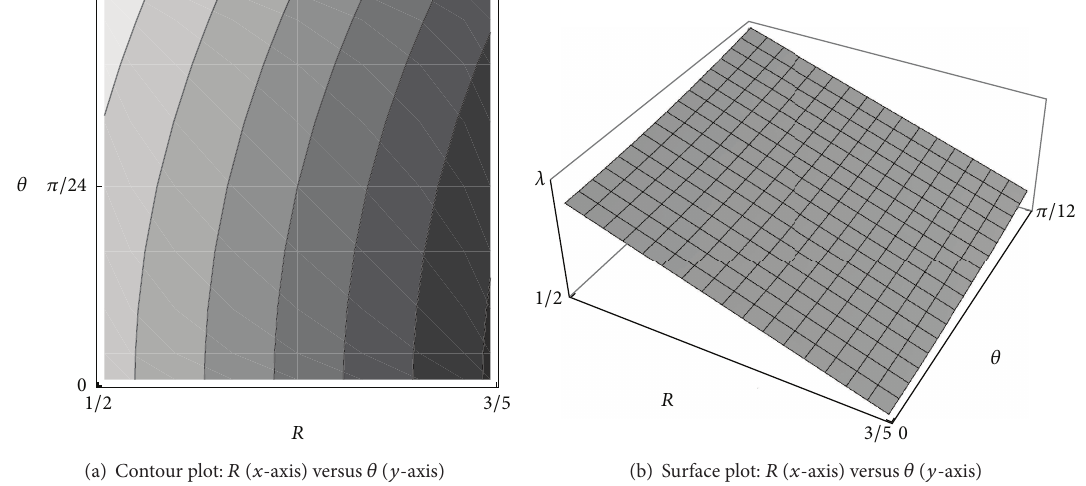
(a) Contour plot: 𝑅 ( 𝑥 -axis) versus 𝜃 ( 𝑦 -axis) (b) Surface plot: 𝑅 ( 𝑥 -axis) versus 𝜃 ( 𝑦 -axis) Figure 3: Case A: eigenvalues over the parameter space: the standard deviation is 𝜎 = 0 . 0008.